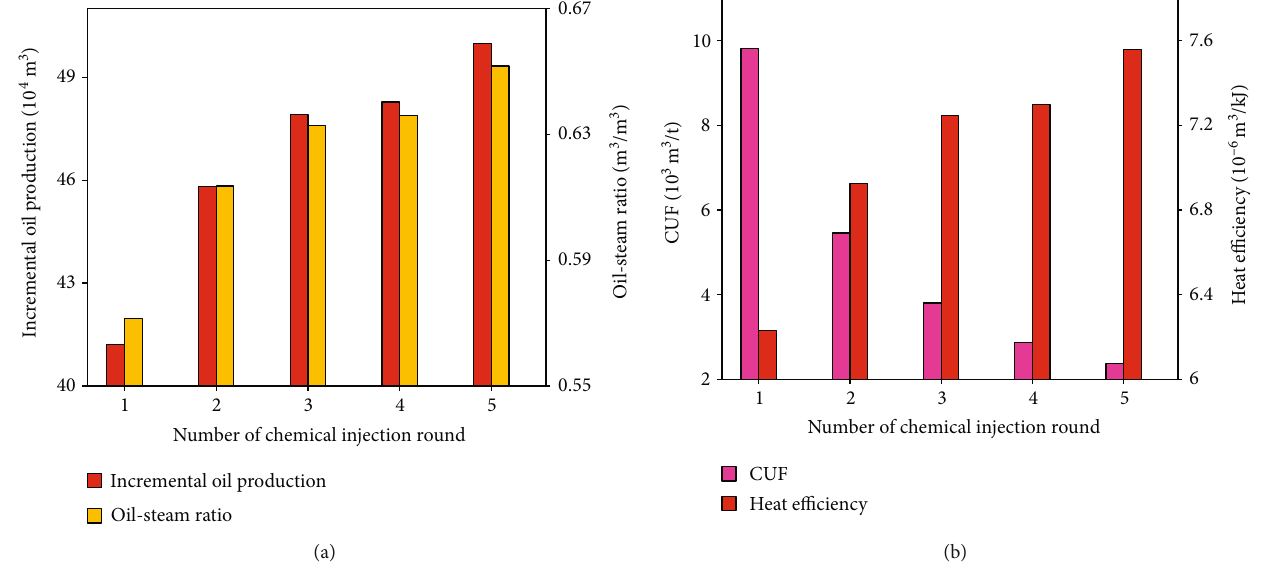
Figure 10: E ff ect of the number of chemical injection round: (a) incremental oil production and oil-steam ratio; (b) CUF and heat e ffi